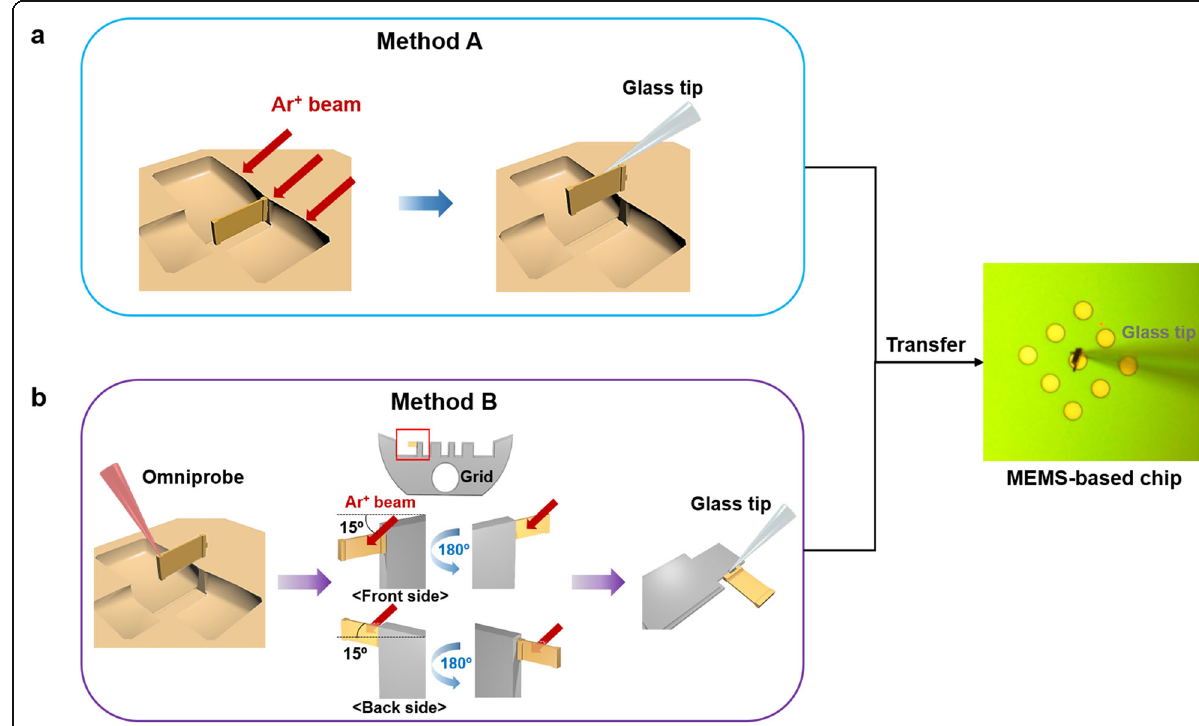
Fig. 1 Schematic of the two different methods of Ar + ion milling to remove Ga + ions. a Performing Ar + ion milling the lamella while leaving it inside the trench, b Performing Ar + ion milling after taking the lamella out of the trench and attacing it to the lift-out